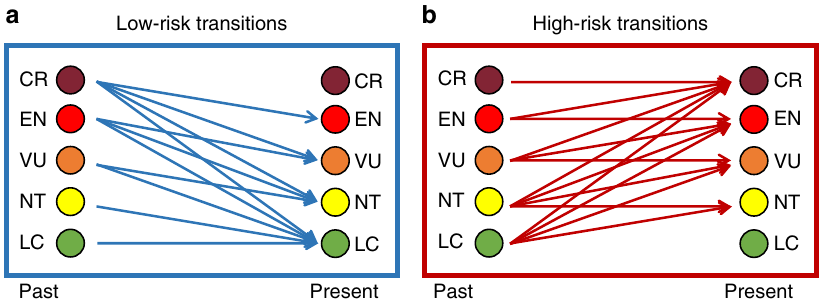
Fig. 1 Classi fi cation of species extinction risk transitions, based on past and present IUCN Red List categories*. Low-risk transitions include those species that were of least concern throughout the study period, together with species that moved from any higher category of threat to a lower one. High-risk transitions include all species that were originally threatened or near threatened and retained their category throughout the study period, together with species that moved from any lower category of threat to a higher category. *Acronyms for the Red List categories: Least Concern (LC); Near Threatened (NT); Vulnerable (VU); Endangered (EN); Critically Endangered